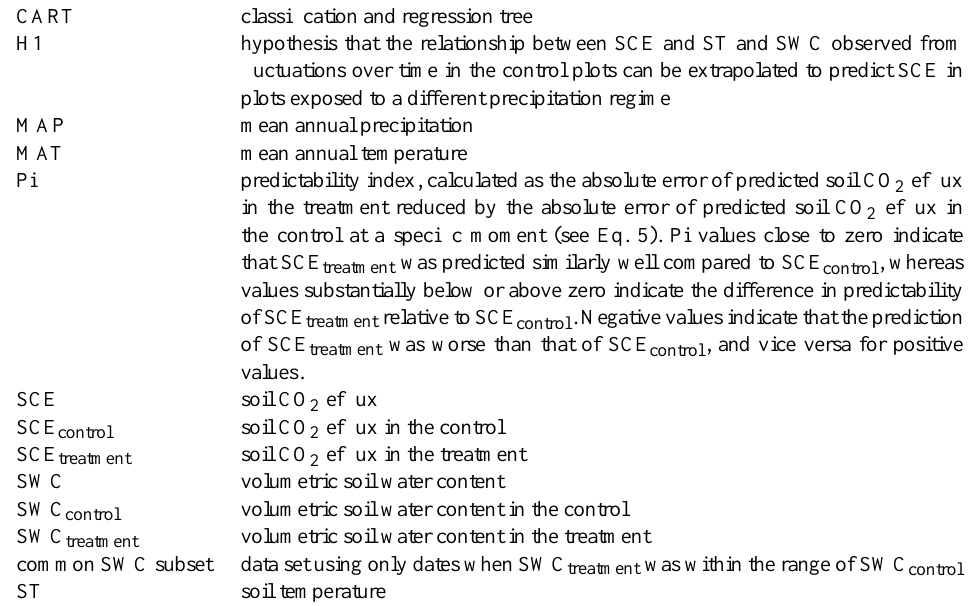
Table D1. List of